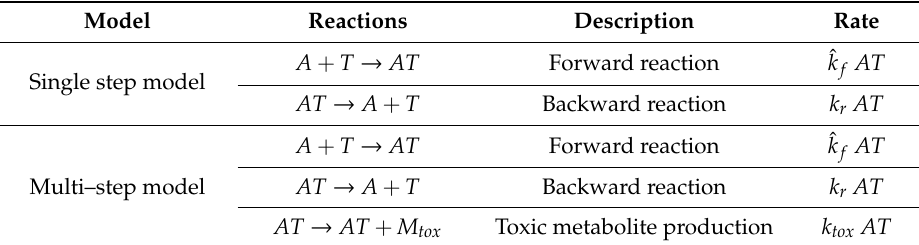
Table 1. Event table and parameter descriptions for Gillespie simulations. Model Reactions Description Rate A + T → AT Forward reaction ˆ k f AT Single step model AT → A + T Backward reaction k r AT A + T → AT Forward reaction ˆ k f AT AT → A + T Backward reaction k r AT Multi–step model AT → AT + M tox Toxic metabolite production k tox AT